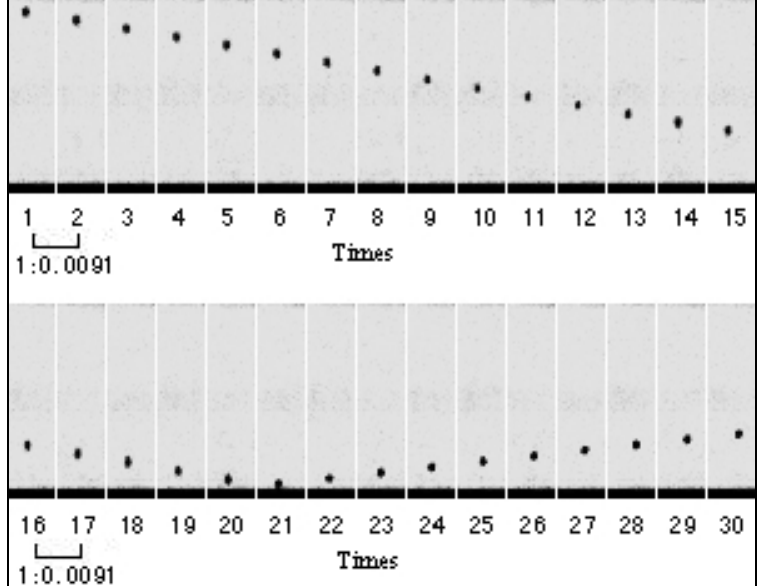
Figure 6. Typical recorded image for the impact of a fly ash particle on a flat